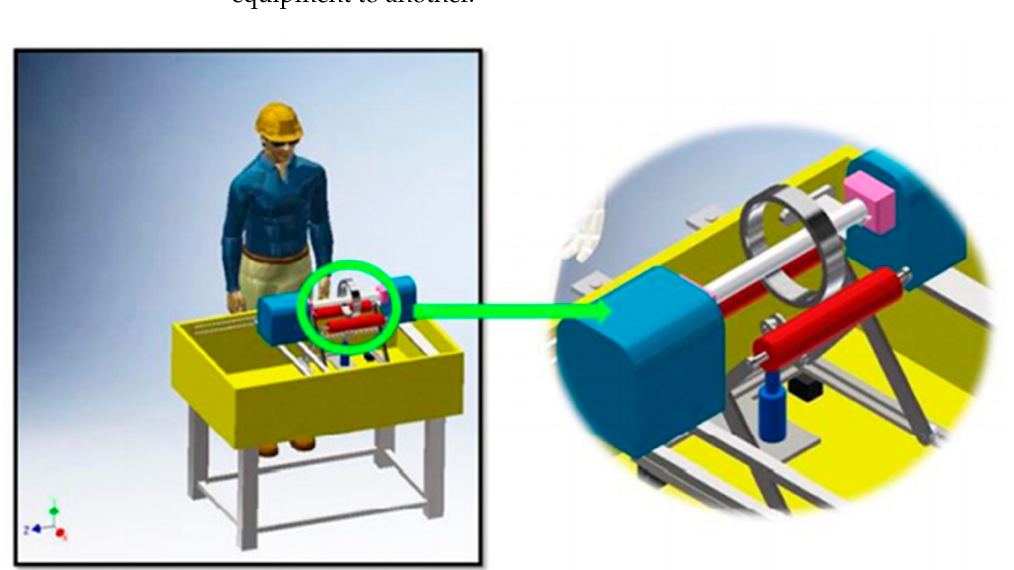
Figure 2. Main view of the device and the optimal position of the part in which the coaxiality is